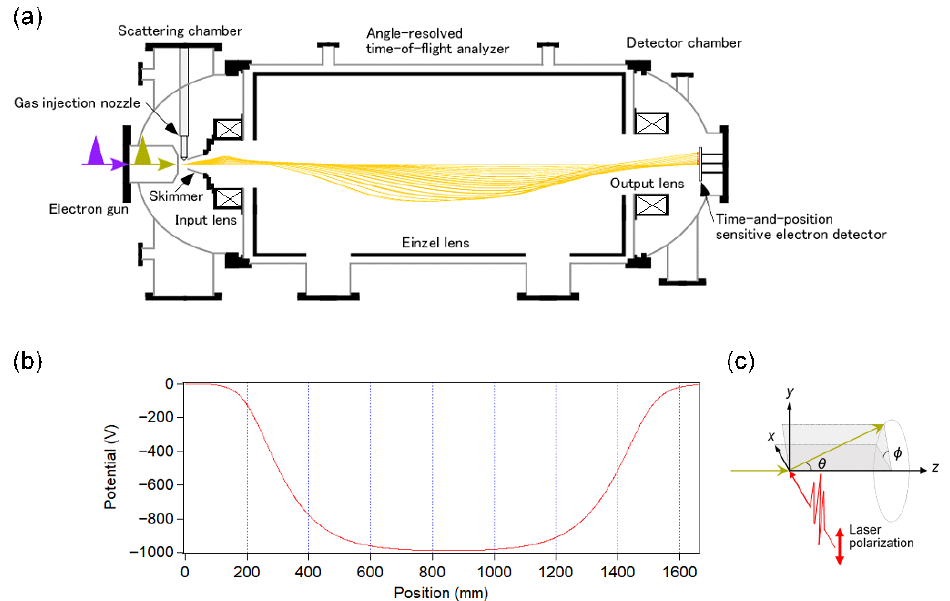
Figure 1. ( a ) The schematic of the second-generation LAES/LAED apparatus. ( b ) The electric potential along the cylindrical axis of the ARTOF tube. ( c ) The definitions of the x , y , and z axes and the polar and azimuthal angles.